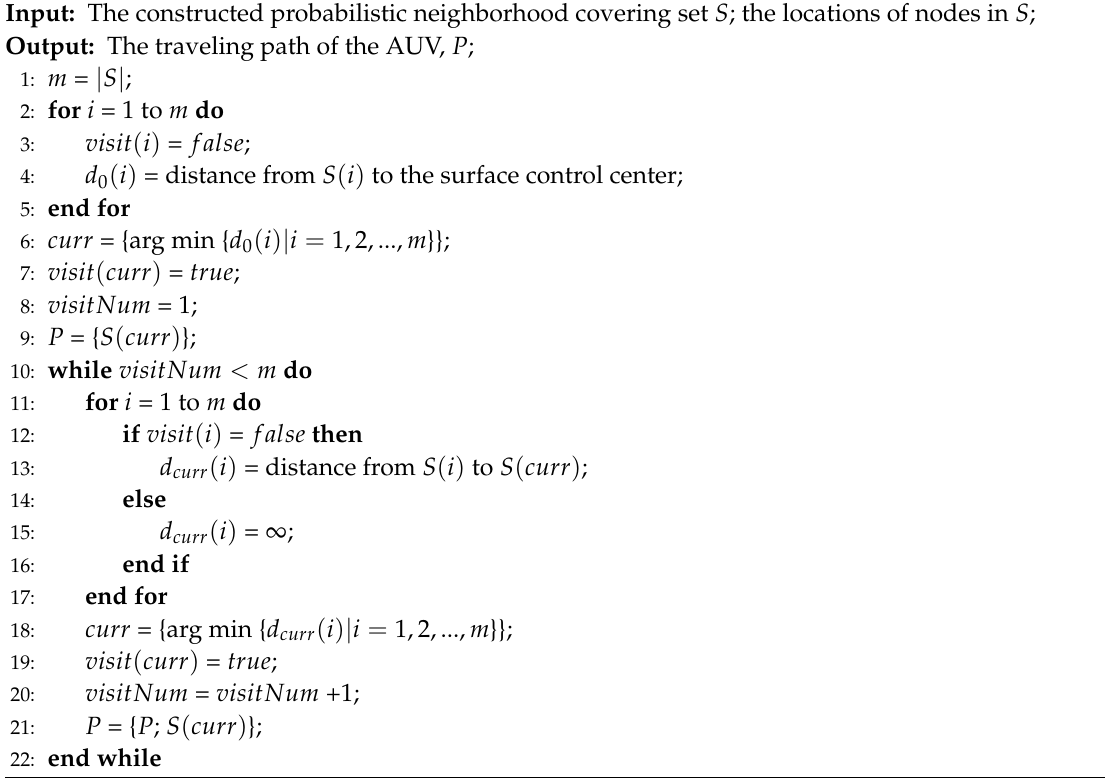
Algorithm 2 Planning the AUV trajectory in